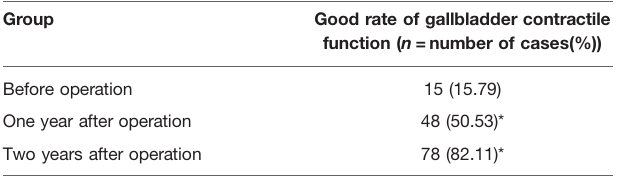
TABLE 2 | Comparison of good rate of gallbladder contractile function before operation and 1 and 2 years after operation ( n [%]).